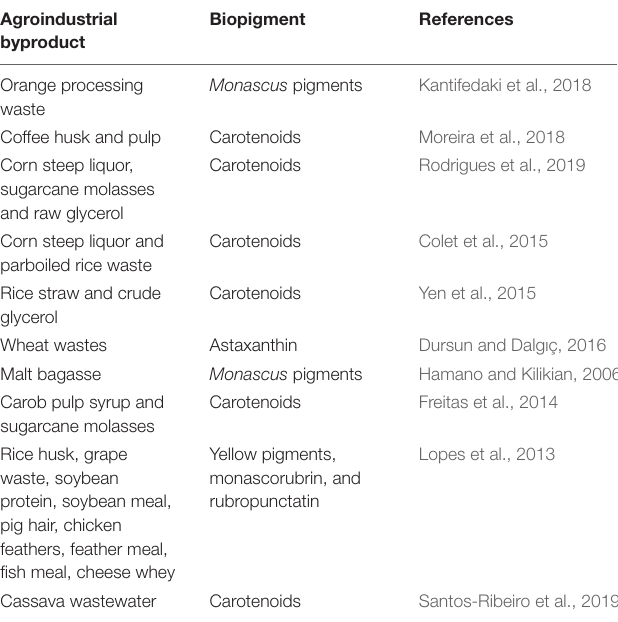
TABLE 3 | Examples of recent researches focusing on the production of biopigments employing agroindustrial